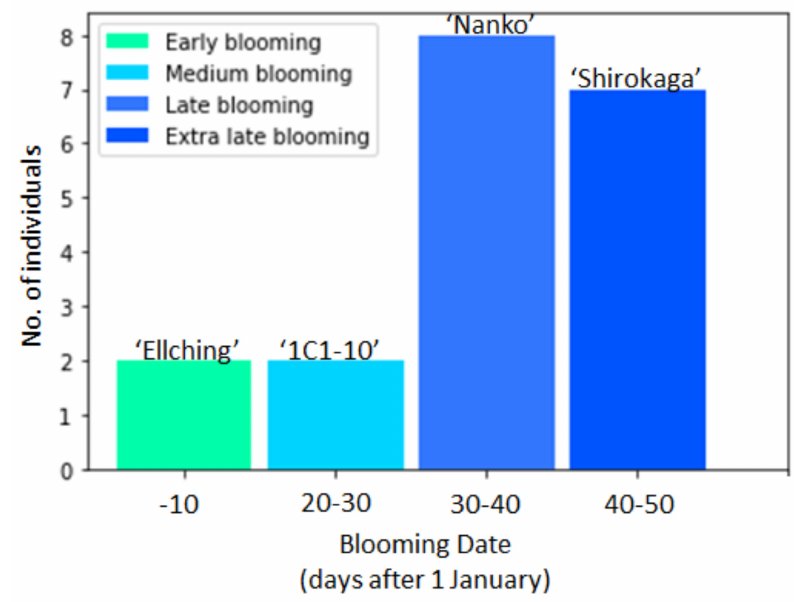
Figure 1. Frequency distribution of blooming dates in the 19 Japanese apricot collections during the 2019–2020 season. ‘Ellching’, early blooming; ‘1C1-10 (cid:48) , medium blooming; ‘Nanko’, late blooming; ‘Shirokaga’, extra late blooming. Table 1. Blooming date (BD) for 19 Japanese apricot cultivars in the 2019–2020